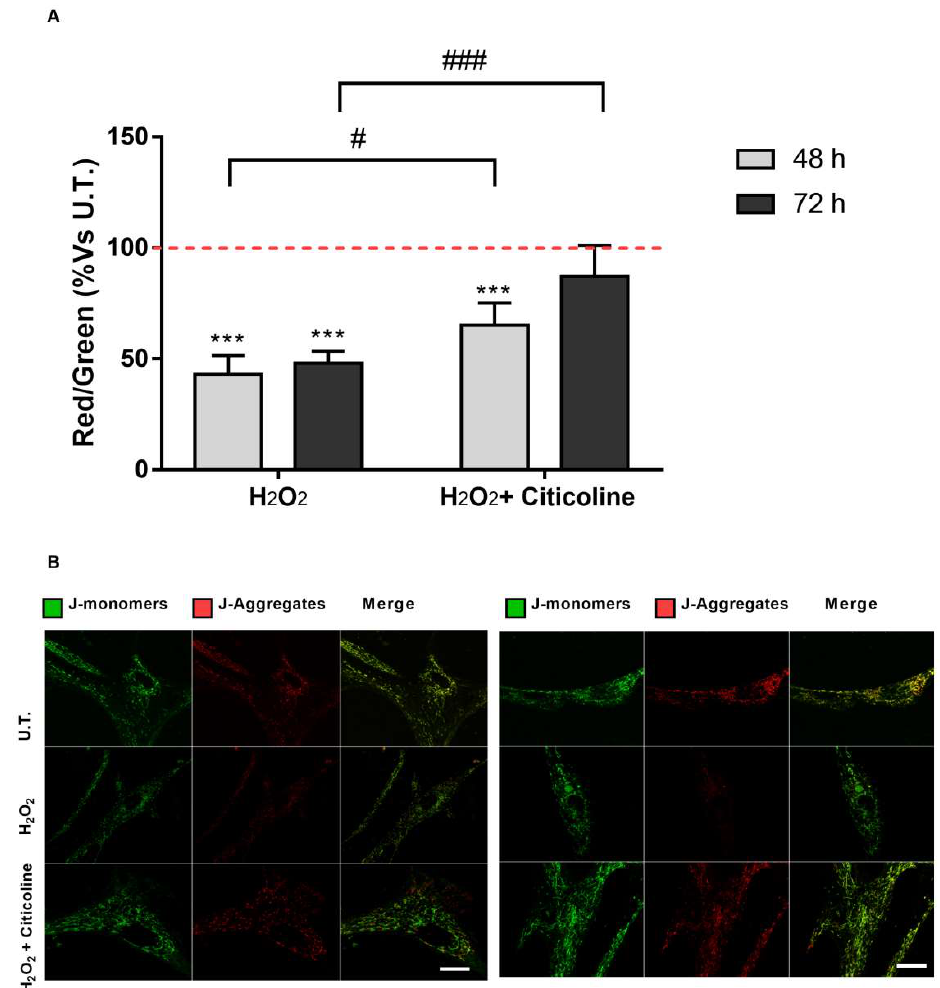
Figure 4. JC-1 assay. The mitochondrial transmembrane potential was monitored under all ex- perimental conditions by JC-1 fluorochrome. ( A ) Quantitative analysis of the ratio of red/green fluorescent intensity was evaluated in HTMCs. The level of red and green intensity was calculated for at least 3 images from the same experimental conditions. Each measurement included ten areas of interest per image. ( B ) The figures depicted are representative of at least three confocal microscopy analyses of the mitochondrial membrane potential ± SD (scale bar marker corresponds to 20 µm). *** p < 0.001 vs. untreated (U.T.) HTMCs; ### p < 0.001, # p < 0.05 vs. treated HTMCs (two-way